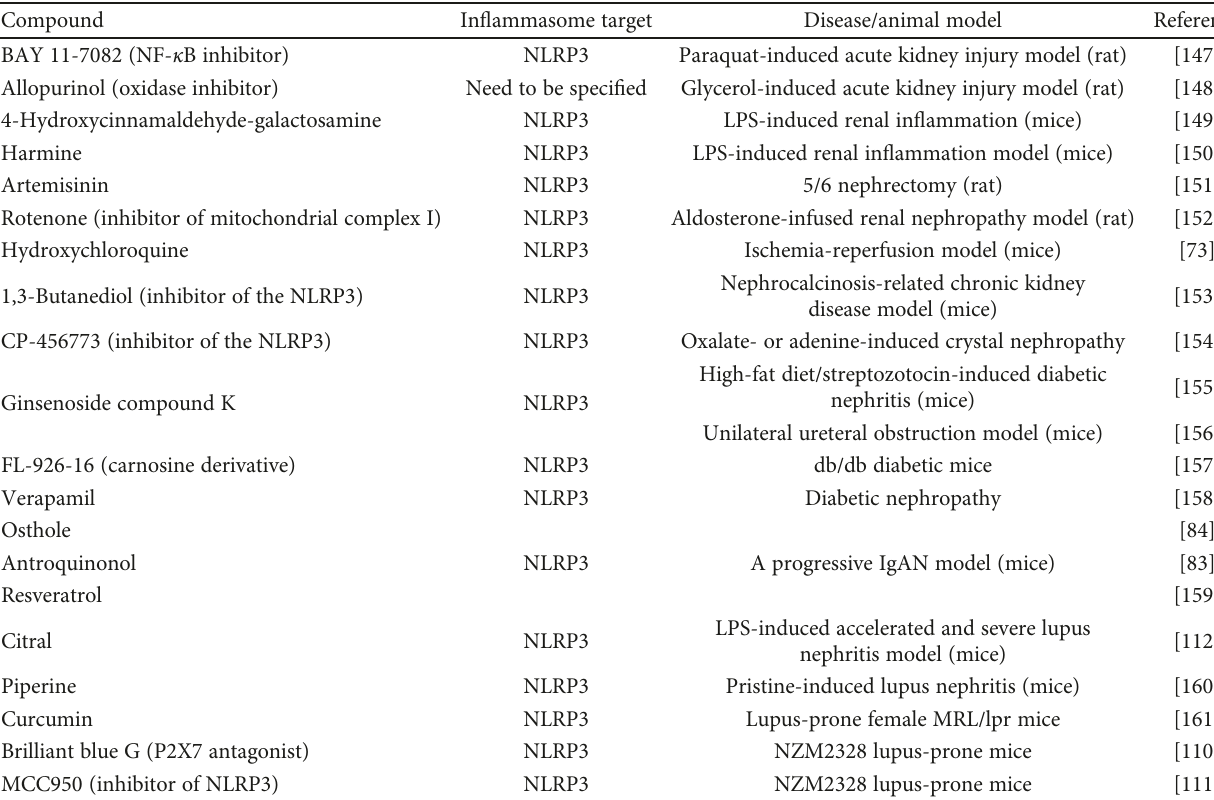
Table 3: Compounds targeting in fl ammasomes for kidney diseases